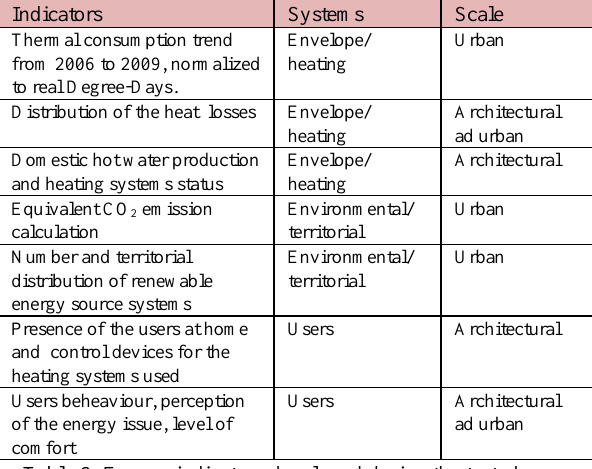
Table 2: Energy indicators developed during the test